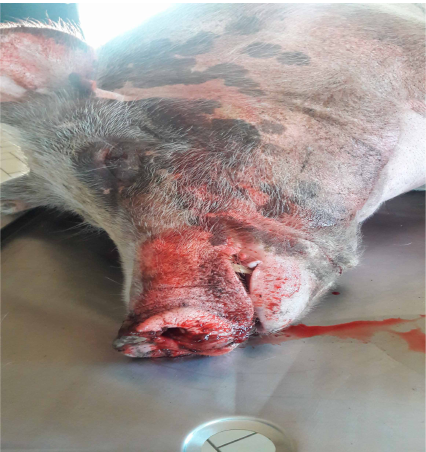
Figure 1: A dead boar with nonclotting blood dripping from the nostrils.